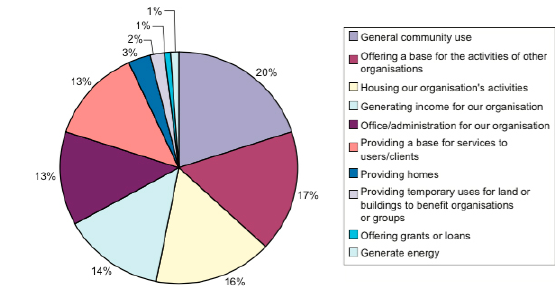
fig. 2. Community asset and purposes according to jrf survey on CBos (aiken et al.